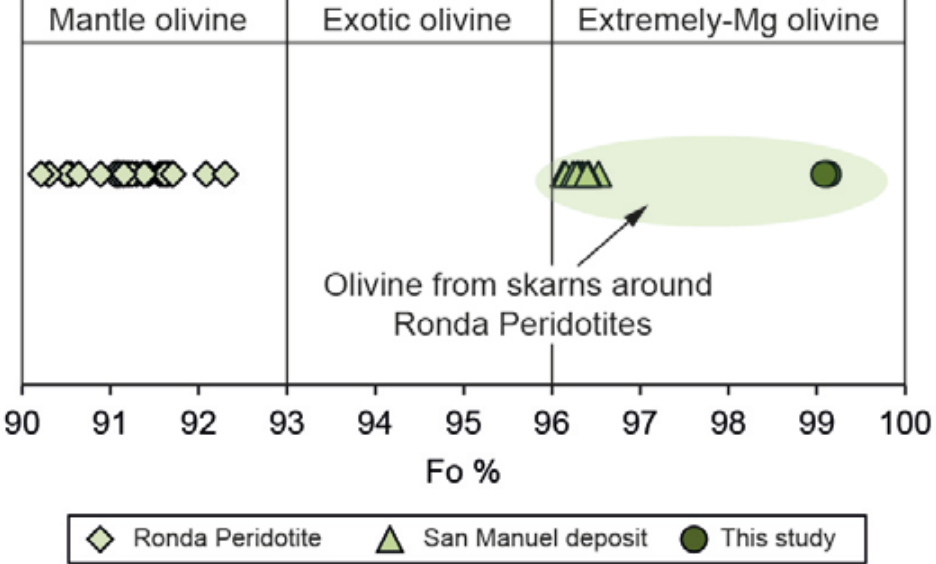
noted between the different amphibole generations. It is worth noting that qualitative